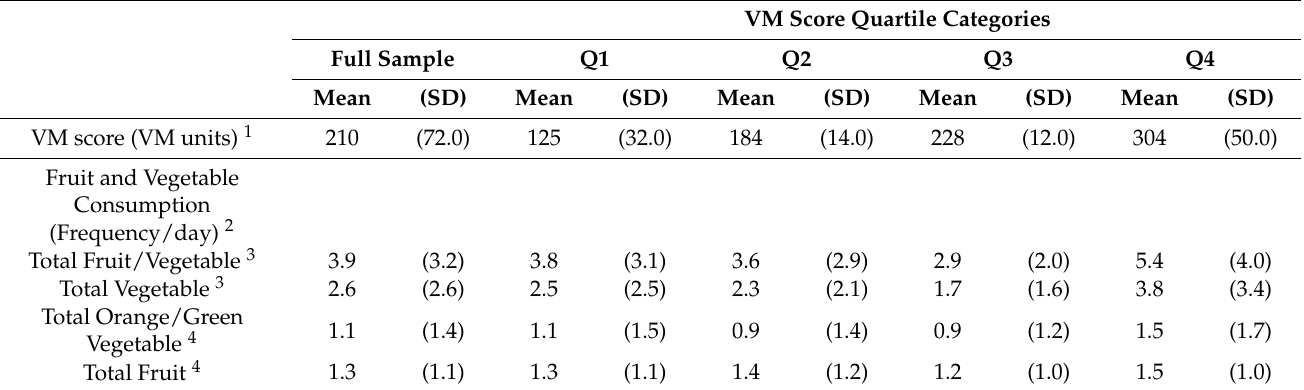
Table 3. Veggie Meter scores and reported fruit and vegetable consumption frequencies by quartile categories of Veggie Meter